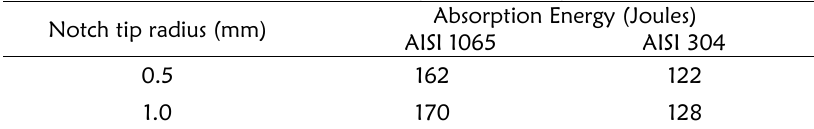
Table 6: Absorption Energy at notch angle of 45°